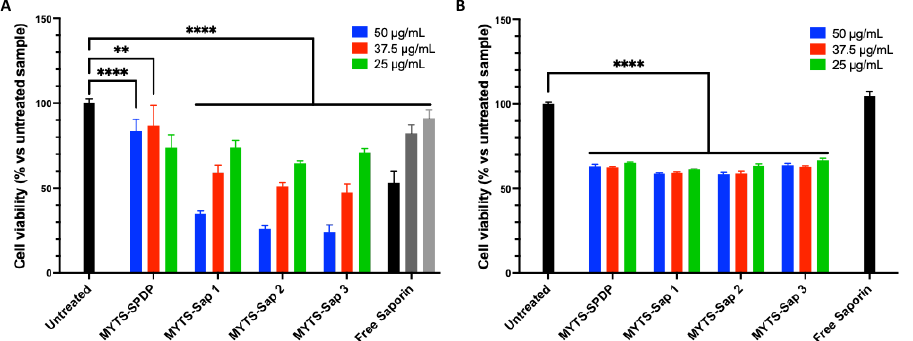
Figure 2. MTT assay performed incubating MYTS-SPDP, MYTS-Sap-1, MYTS-Sap-2 and MYTS-Sap- 3 at concentrations of 25, 37.5 and 50 µg/mL with ( A ) SK-BR-3 cells and ( B ) for NIH-3T3 cells for 24 h. Corresponding Saporin concentrations (nM) are reported in Table S1. For free Saporin samples, approximately 2× (light gray), 3× (dark grey) and 4× (black) the maximum Saporin concentrations tested with MYTS-containing samples (50 µg/mL MYTS-Sap-3, 111.1 nM) were used for SK-BR-3, and the maximum concentration was used for NIH-3T3. **** p < 0.0001, ** p < 0.01 vs. untreated (black).